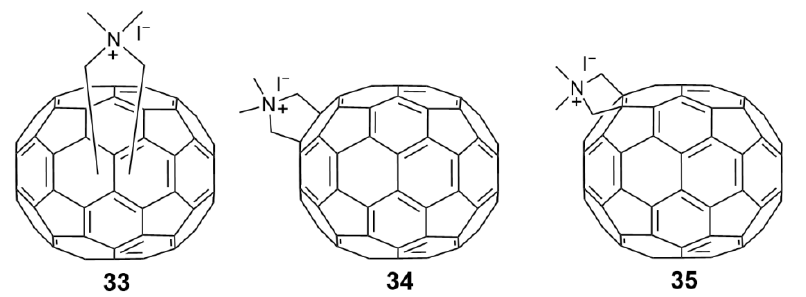
Figure 11. Chemical structures of the cationic N , N -dimethyl [70]Fullerene pyrrolidine iodide deriv- atives ( 42 – 44 ). derivatives ( 42 – 44 ).